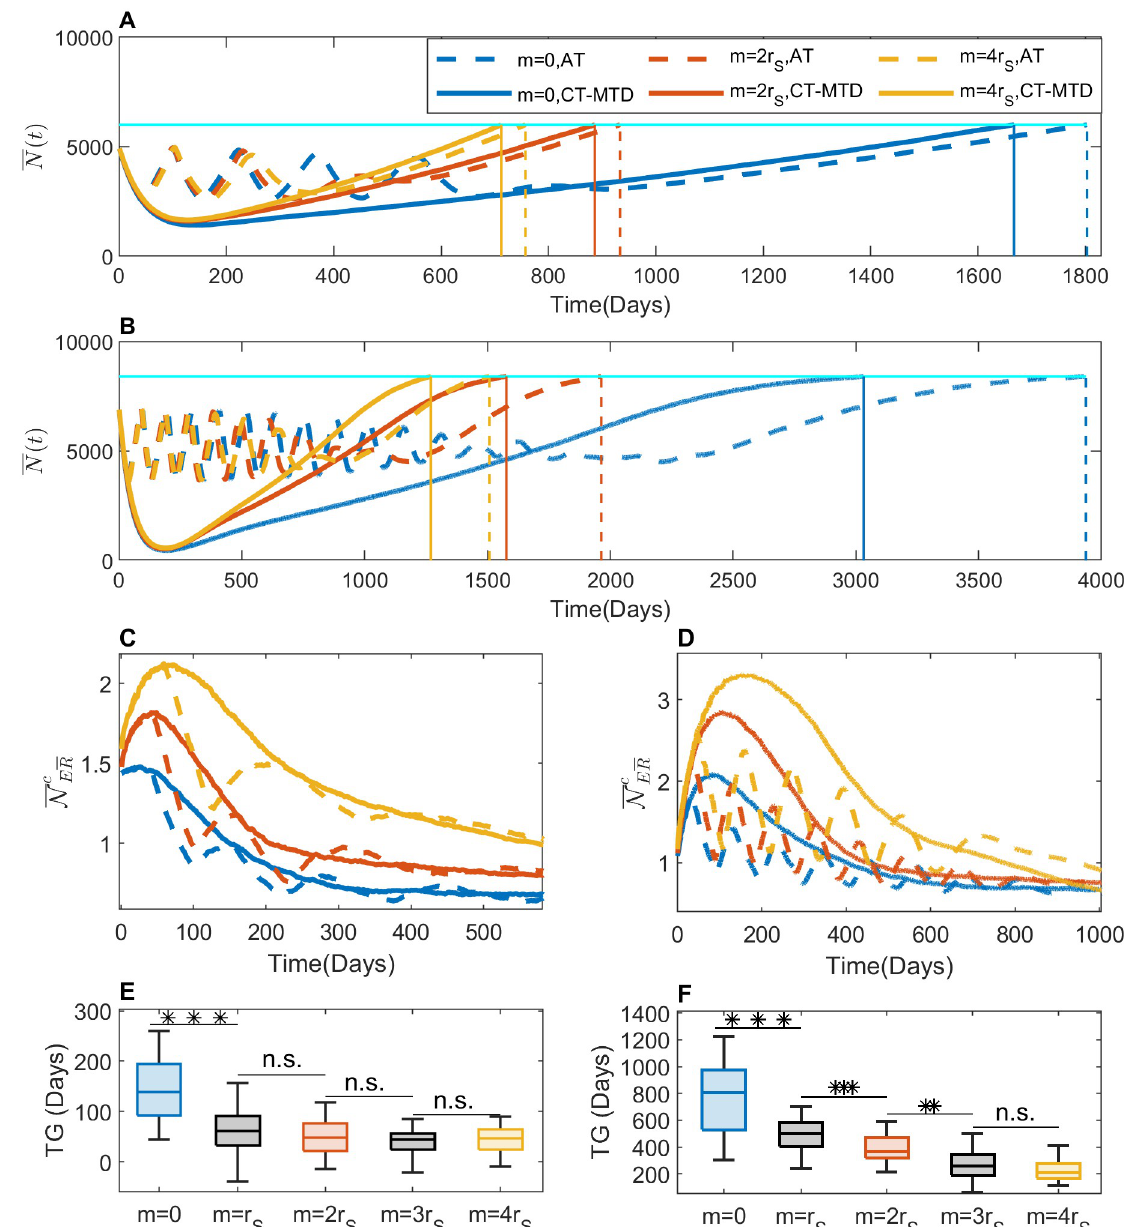
Fig 7. Effects of cell migration on treatment responses. ( A ) The time evolution of the mean of the total cell population ( � N ð t Þ ) in the 30 simulations is shown for m = 0 (blue), 2 r S (red), and 4 r S (yellow) under AT (dashed line) and CT-MTD (solid line) with N (0) = 5000, f 0 = 10%. The vertical solid lines show the time to tumor progression (TTP) under CT-MTD. The vertical dashed line shows the TTP under AT. The horizontal cyan line shows the 120% level of the initial cell population (progression threshold). ( B ) The same result as in A is shown for N (0) = 7000, f 0 = 1%. ( C ) The time evolution of the mean of the average number of empty sites in the VNHD of each R-cell in the 30 realizations ( � N i ð t Þ ) is shown with the same line styles as in A. ( D ) The same result as in C is shown for N (0) = 7000, f 0 = 1%. ( E ) The E � R boxplots of the TG for m = 0, r S , 2 r S , 3 r S , 4 r S are shown. ( F ) The same result as in D is shown for N (0) = 7000, f 0 = 1%.